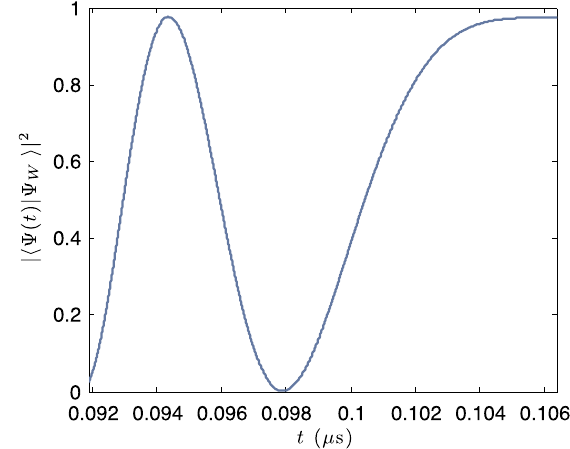
FIG. 7. Fidelity of the system state j (cid:1) ð t Þi with the target state j entanglement protocol with system parameters (cid:1) = 2 (cid:3) ¼ 30 MHz , and M ¼ 3 and damping as 100 MHz , (cid:2) max explained in the text. The input state is j c